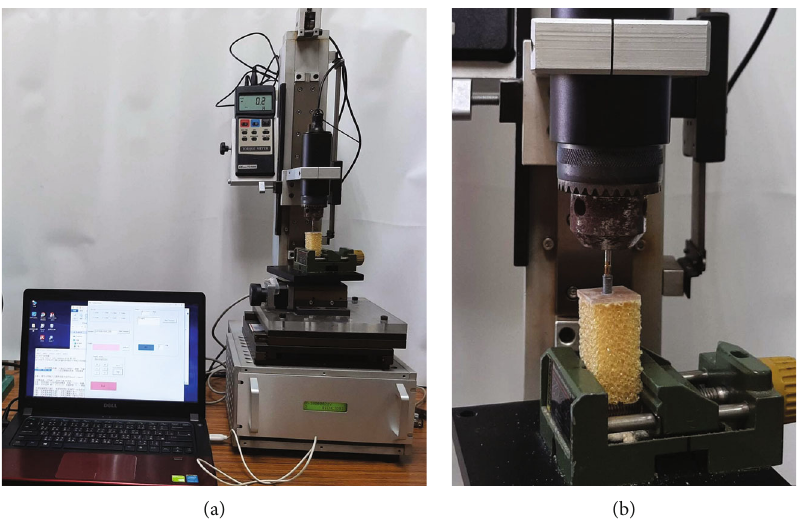
Figure 2: Measurement of the insertion torque value: (a) entire view; (b) closed